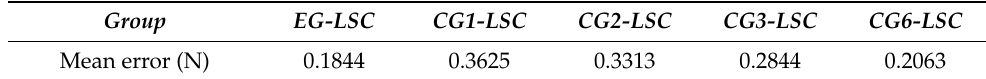
Table 4. Mean errors of each method.